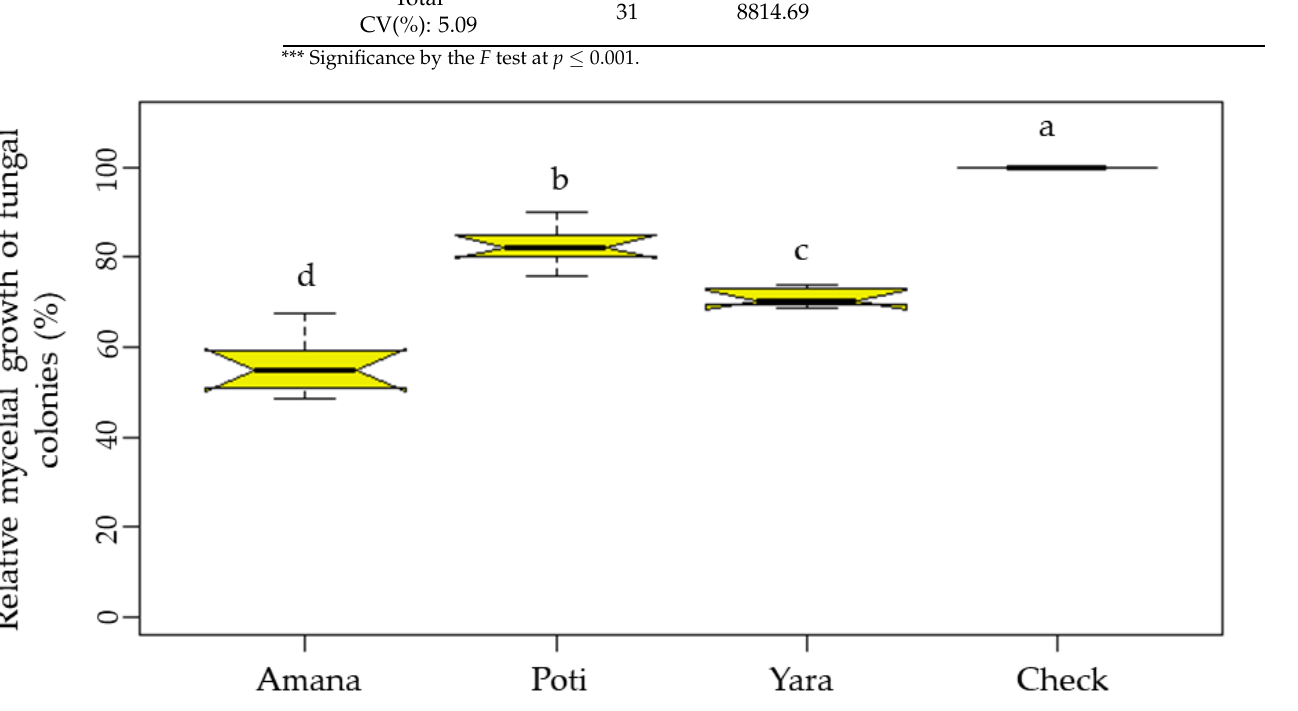
Figure 1. Boxplot distribution of the relative mycelial growth of Pyricularia oryzae Triticum lineage ( PoTl ) under in vitro antagonism by three strains of fluorescent Pseudomonas species. Each boxplot represents the distribution of values from 3 PoTl isolates (12.1.047, 12.1.146, and 12.1.207). Means followed by the same letters (a–d) are not significantly different using the Tukey test at p ≤ 0.05.